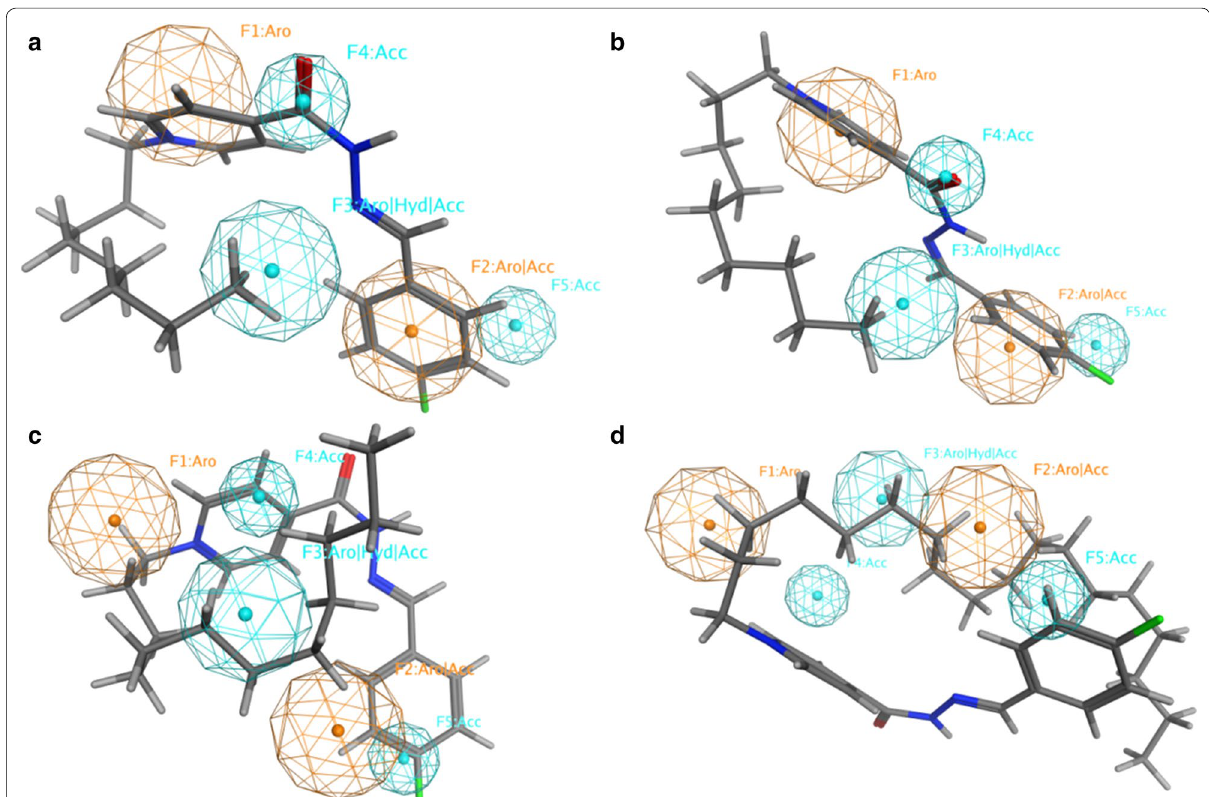
Fig. 5 PI3Kα inhibitor pharmacophore model with a 2 , b 3 , c 6 , and d 9 . Aro stands for aromatic ring; Acc for H‑bond acceptor; and Hyd for hydrophobic group. Picture made by MOE 52